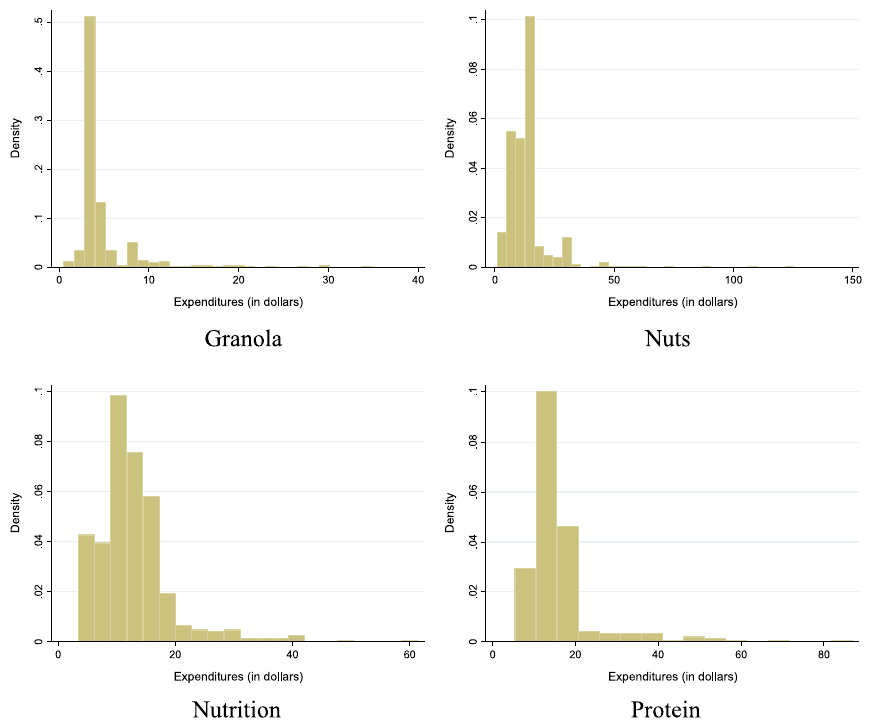
Fig. 2 Distributions of hemp products expenditures in original